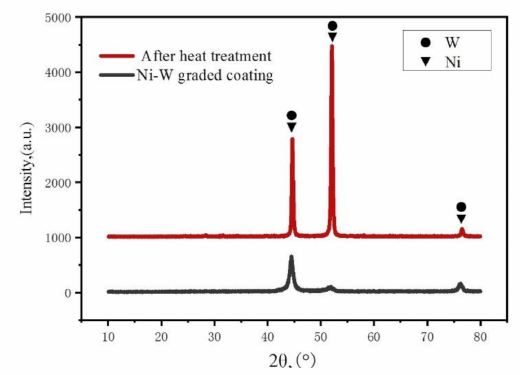
Figure 9. XRD of Ni–W alloy coating and Ni–W graded coating.